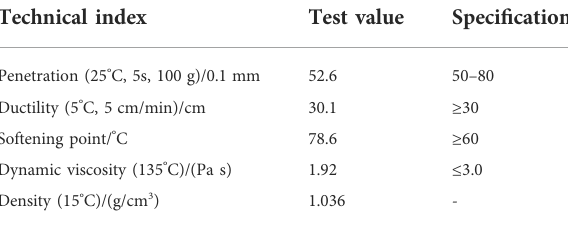
TABLE 1 Technical performance indexes of SBS-modi fi ed